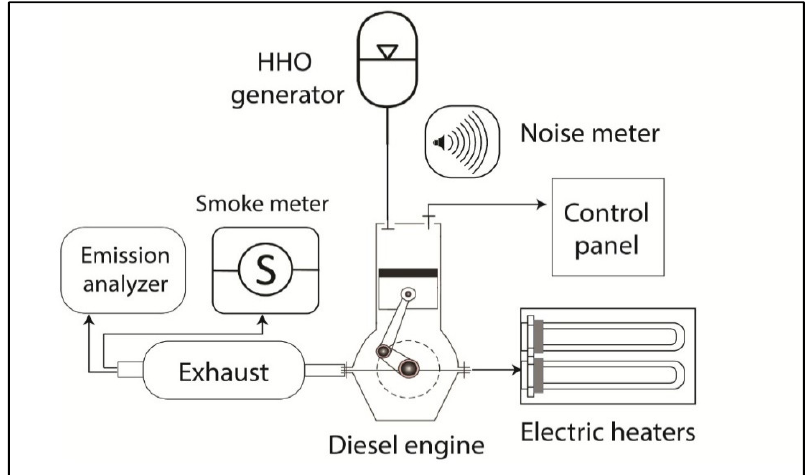
Figure 1. Schematic of the experimental Setup.